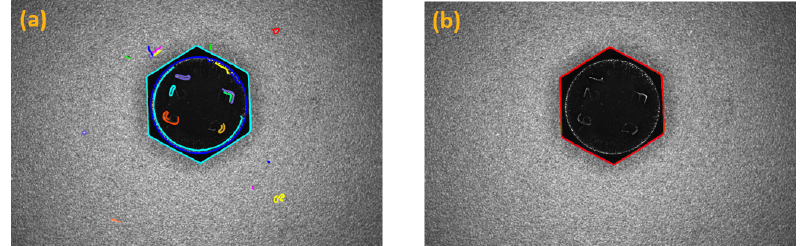
Figure 15. Edges extracted from screw images. ( a ) Edges extracted with Canny filter. ( b ) Edges used to describe the screw-head feature.